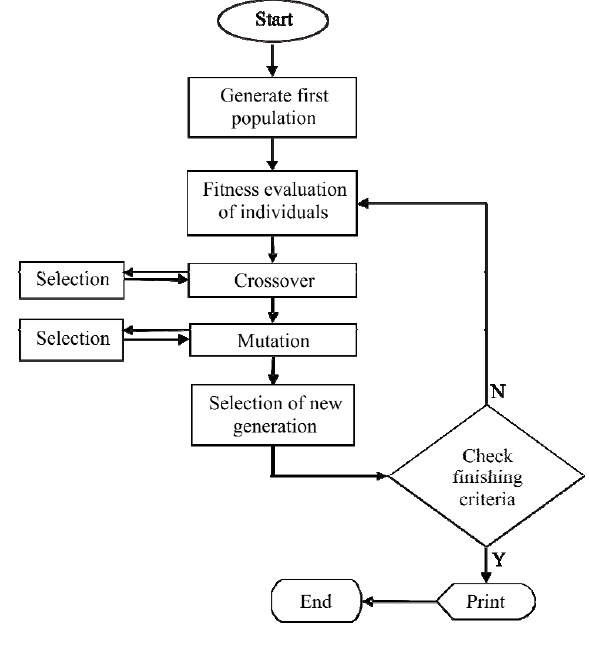
Table 4. Input parameters and function